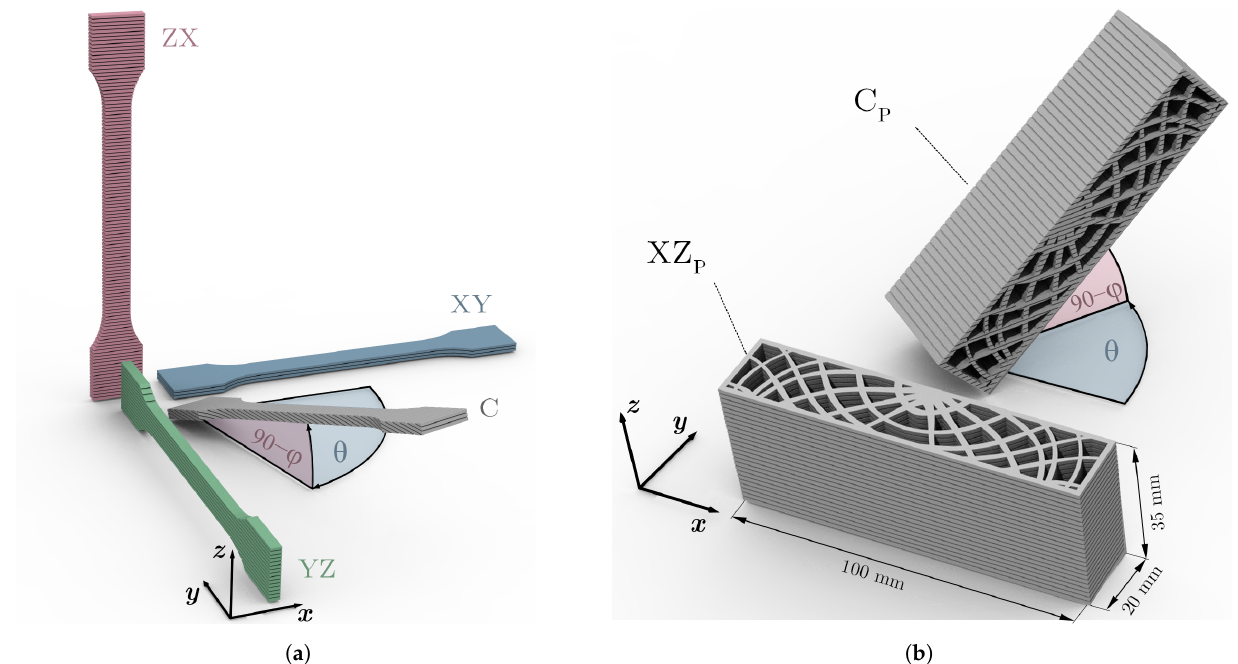
Figure 2. Visualization of specimen orientations with ( a ) tensile coupons for material model setup (XY, ZX, XZ) and control thereof (C) as well as ( b ) a thin-walled part of variable thickness in principal axes aligned (XZ P ) and arbitrary (C P )